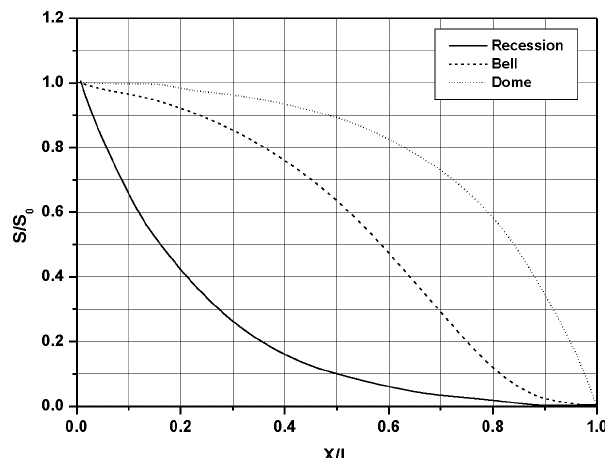
Figure A1. Three types of salt intrusion curves, in which L is the salt intrusion length, x is the distance from the mouth, S is the salin- ity at the mouth and S 0 is the salinity corresponding with the dis-